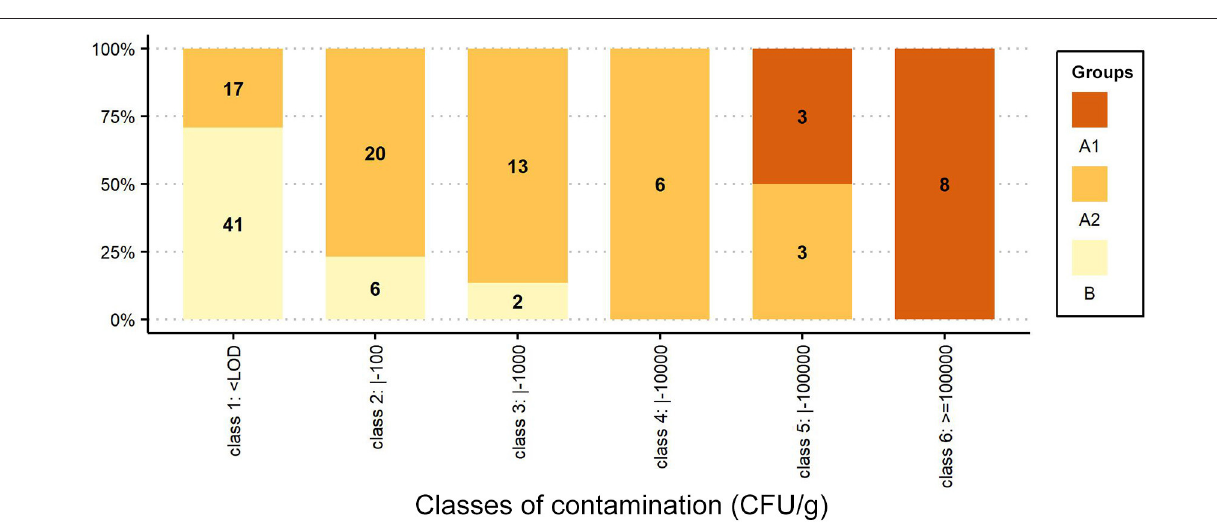
FIGURE 2 | Percentage distribution of samples/colonies grouped by classes of contamination (CFU/g). The number of samples/colonies is shown inside each